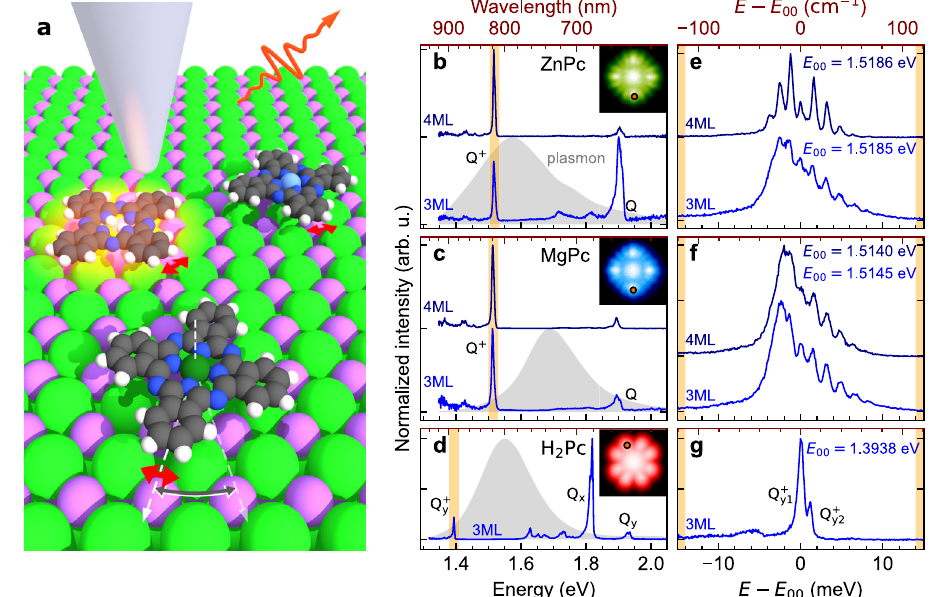
Fig. 1 | STM-EL characterisation of phthalocyanines and high-resolution spec- traoftheircations.a SchemeoftheSTM-ELmeasurementoftheMgPc,H 2 Pc,ZnPc molecules(fromtoptobottom,respectively),performingin-planelibrationsonthe surface of NaCl/Ag. The red arrow denotes small-energy librations while the grey arrow represents switching between two degenerate chiralequilibrium adsorption positions. b – d Overview STM-EL spectra of the ZnPc, MgPc and H 2 Pc at − 2.8V, 100pA, showing the neutral ( Q , Q x , Q y ) and cation ( Q + , Q y + ) emission fi ngerprints plotted with blue solid lines. Grey- fi lled spectra on the background of each panel are the responses of the nanocavities measured on a clean Ag(111) surface at 2.5V,